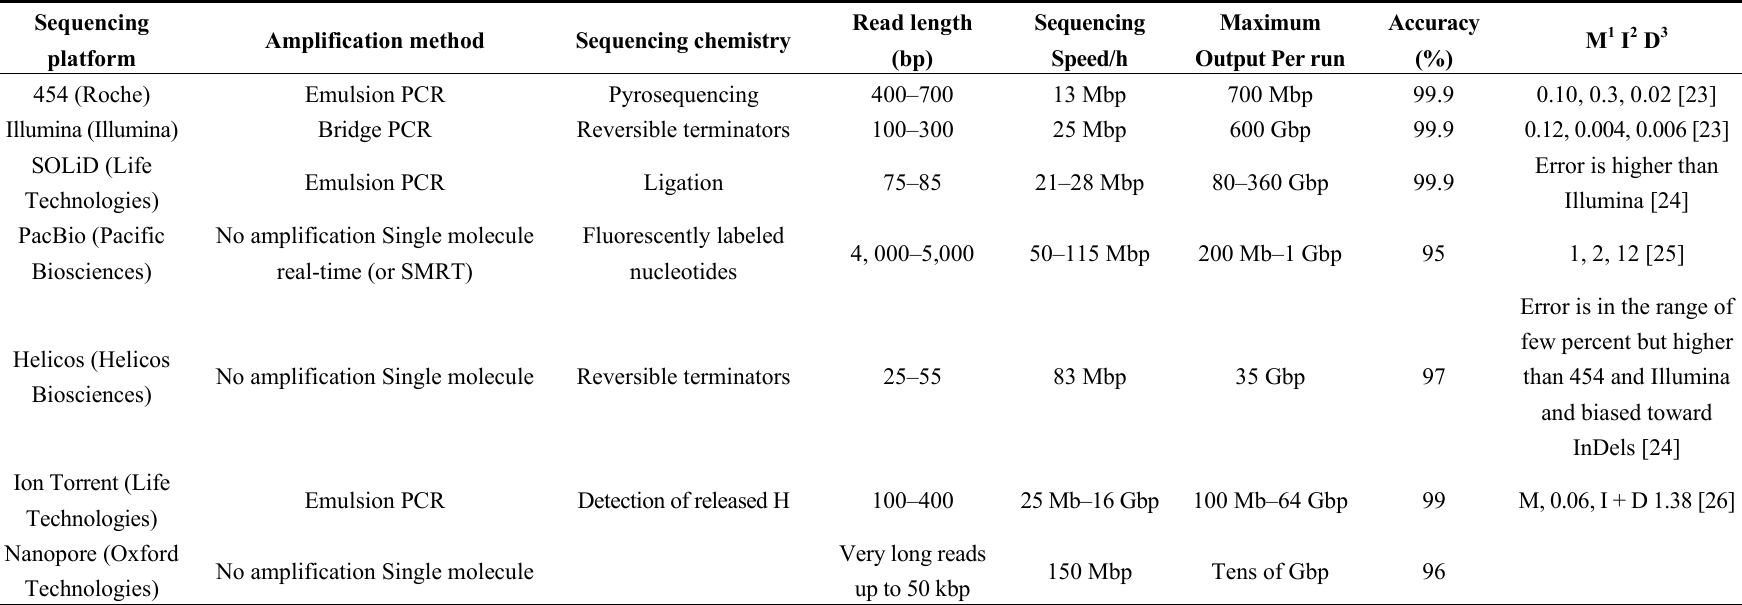
Table 1. Current major m1ethods of next-generation DNA sequencing technologies.